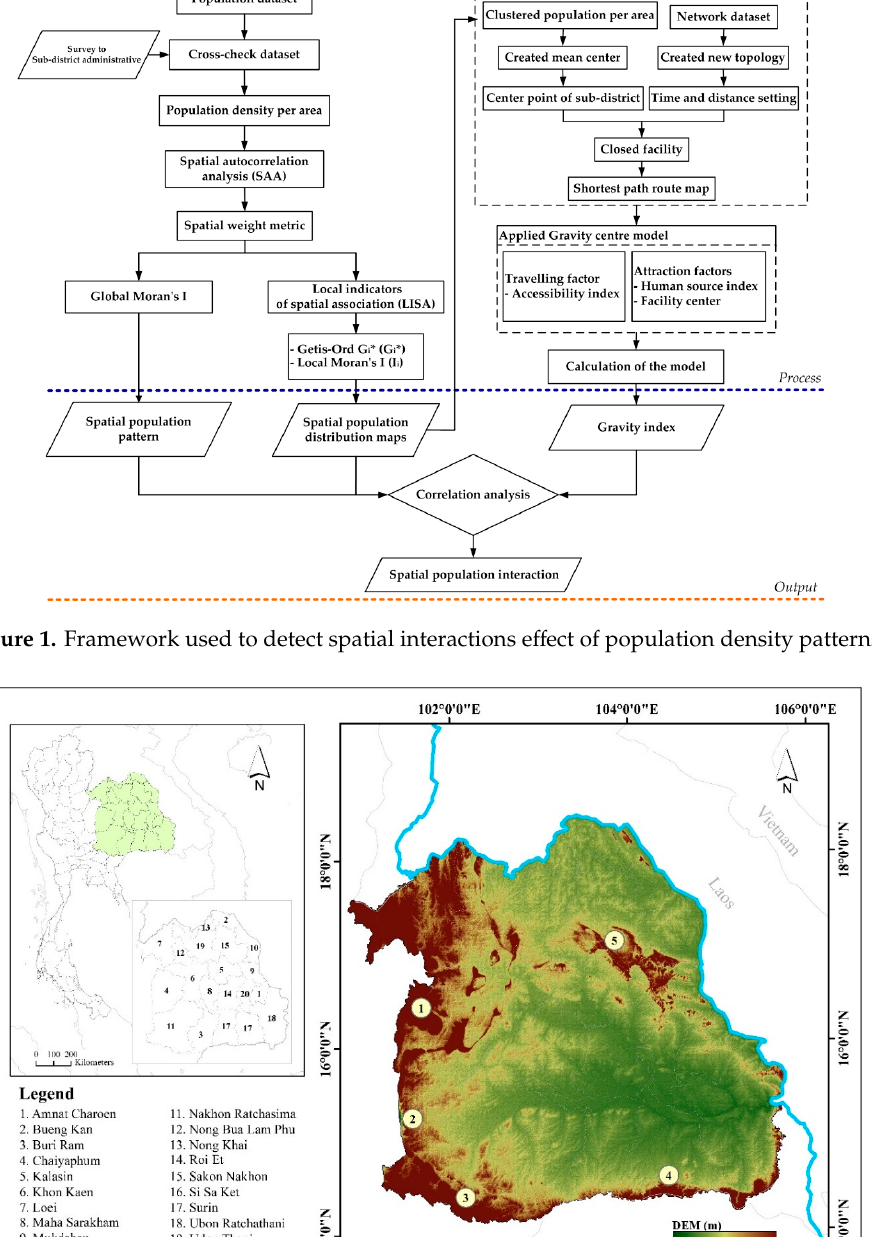
Figure 2 . Study area. Figure 2. Study